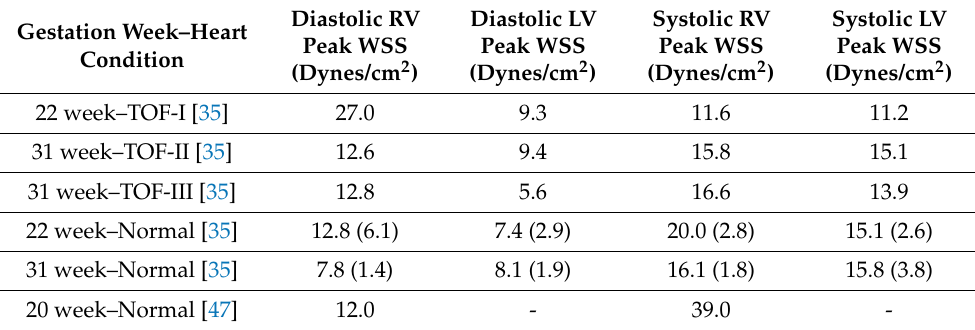
Table 3. Comparison of peak WSS levels of normal and three TOF (tetralogy of fallot) human fetal hearts at different gestational stages (LV: left ventricle, RV: right